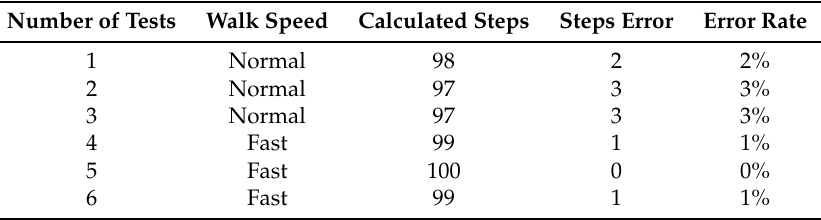
Table 2. Tests of step count